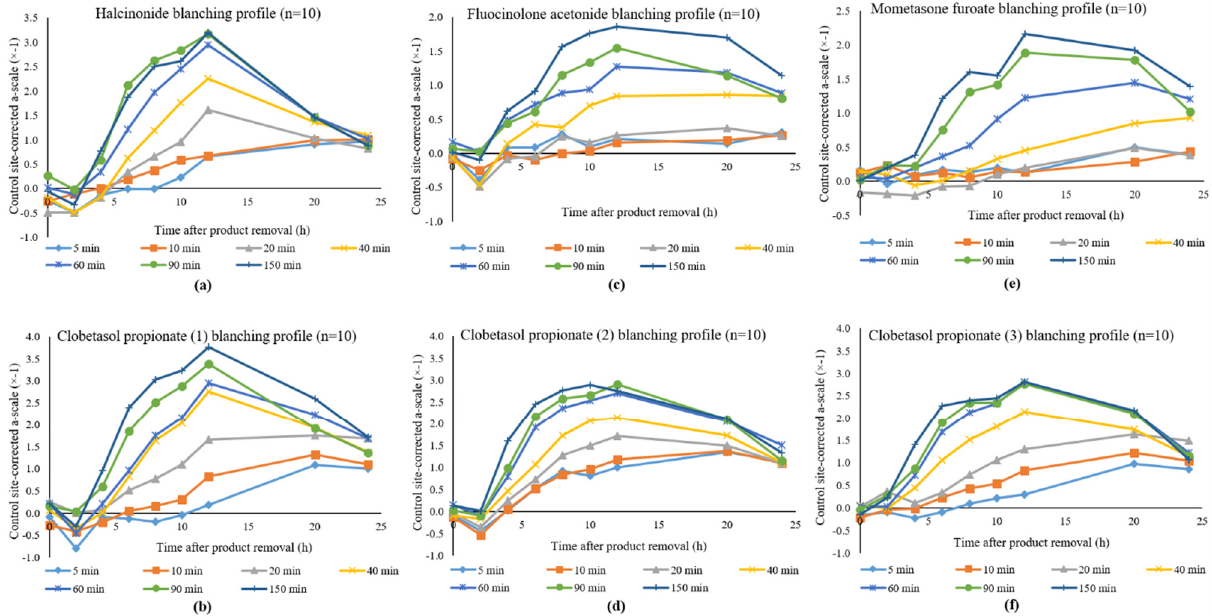
Figure 2. Blanching profiles for ( a ) halcinonide; ( b ) clobetasol propionate (1); ( c ) fluocinolone acetonide; ( d ) clobetasol propionate (2); ( e ) mometasone furoate; ( f ) clobetasol propionate (3).